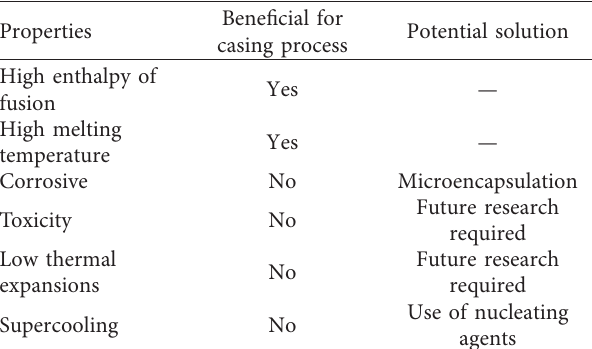
Table 4: Properties of inorganic PCM studied in present